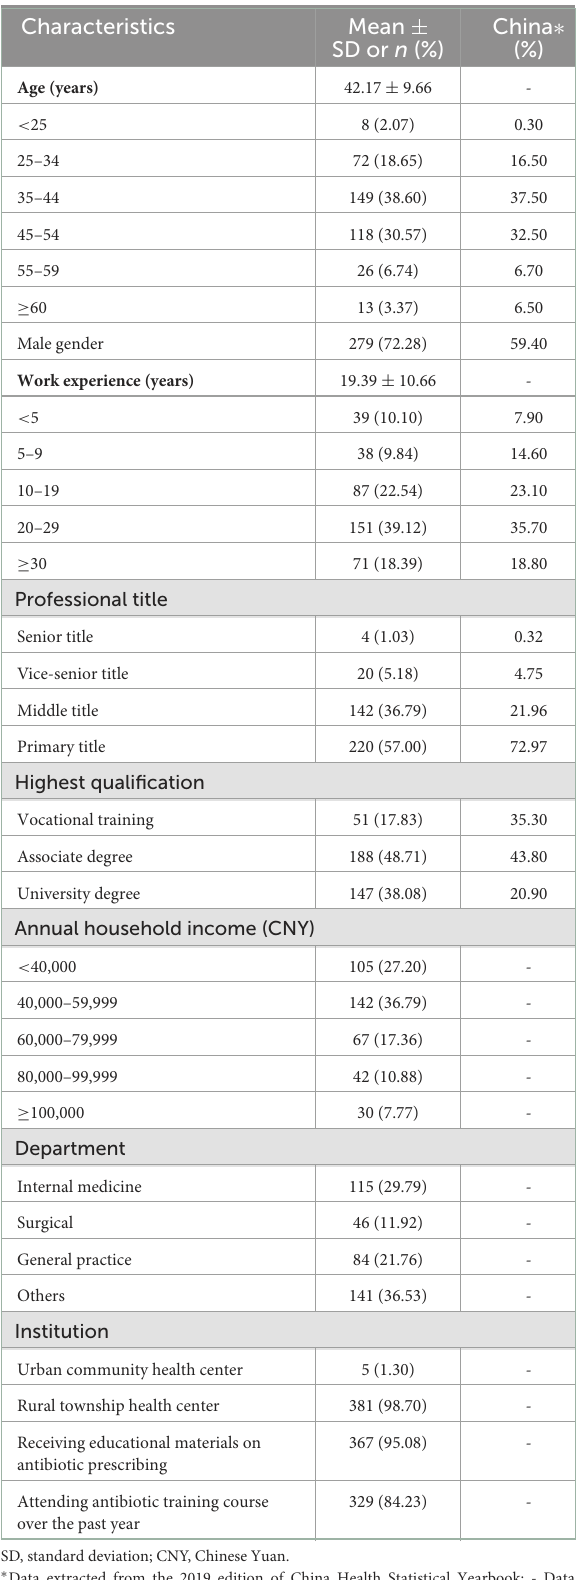
TABLE 3 Demographic characteristics of study participants in discrete choice